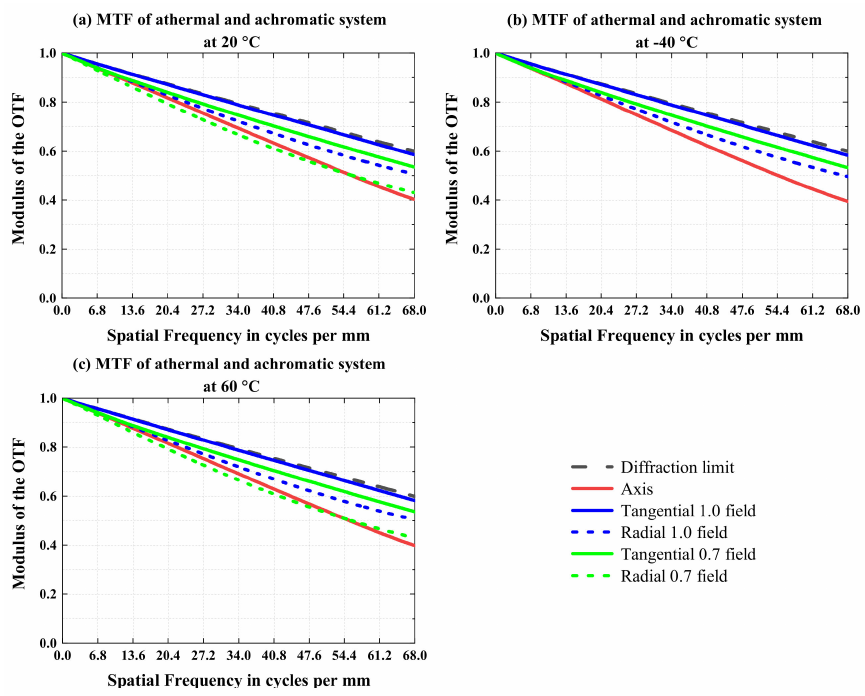
Figure 16. MTF performance of the final athermal optical system at temperatures of ( a ) 20 ◦ C, ( b ) − 40 ◦ C, and ( c ) 60 ◦